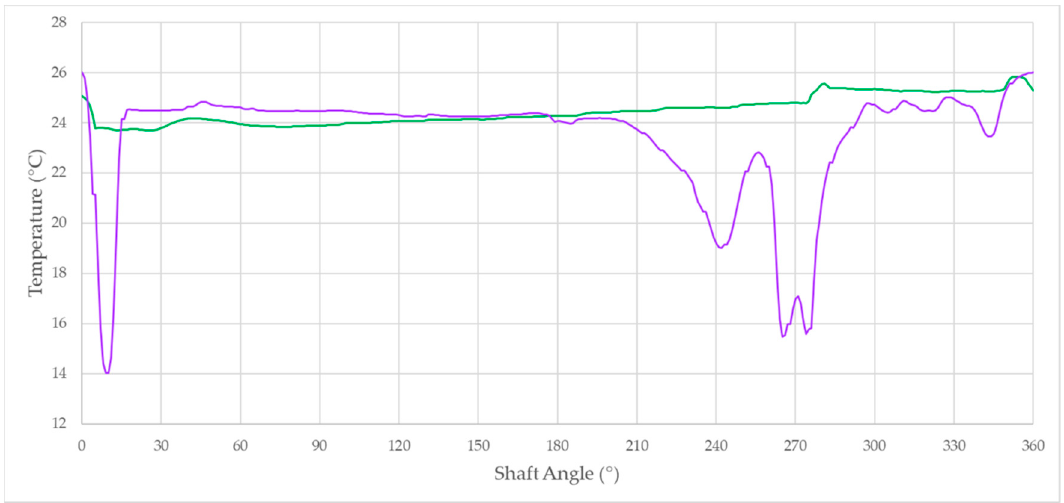
Figure 18. Temperature within a displacement chamber of the pump (green) and in the 30- μ m axial gap